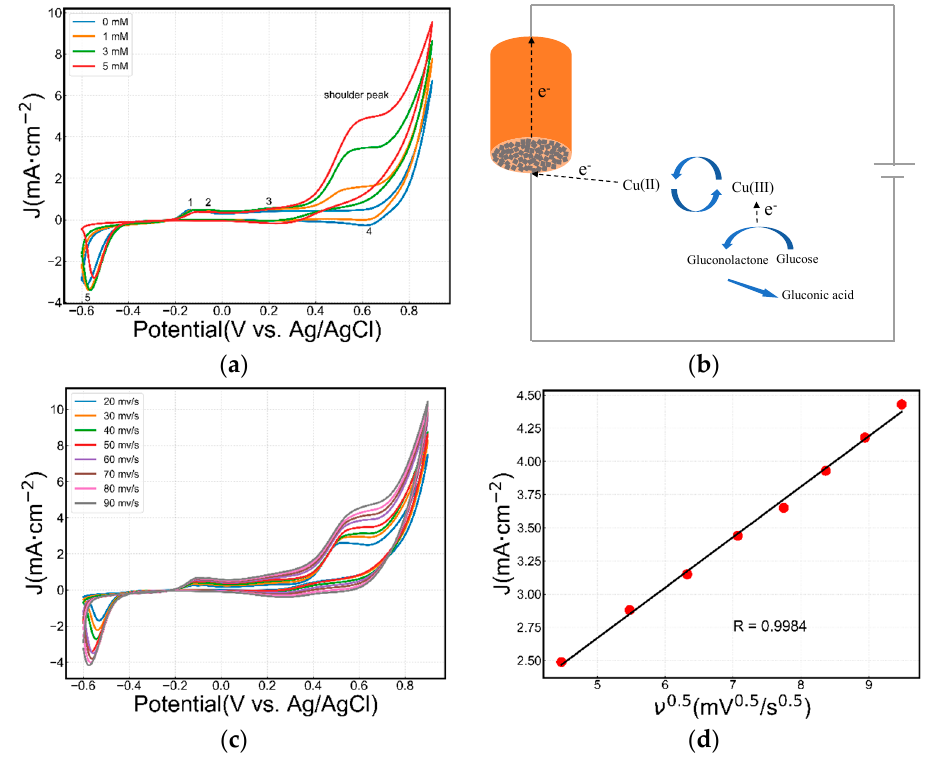
Figure 2. ( a ) Cyclic voltammograms (cathodic sweep first) of a Cu 2 O electrode in 50 mM NaOH electrolyte. Scan rate: 50 mV/s. ( b ) Mechanism of glucose oxidation on the Cu 2 O electrode. ( c ) Cyclic voltammograms (CVs) of the Cu 2 O electrode at scan rates varying from 10–90 mV/s in 50 mM NaOH solution containing 3 mM glucose. ( d ) Linear regression of the peak current and square root of the scan rate.